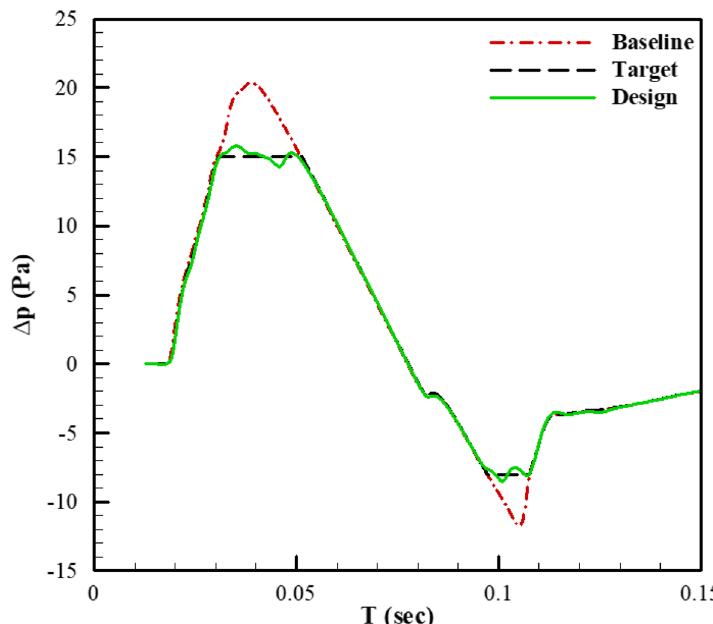
Fig. 19 Optimized ground signature matching a physically non-existent target